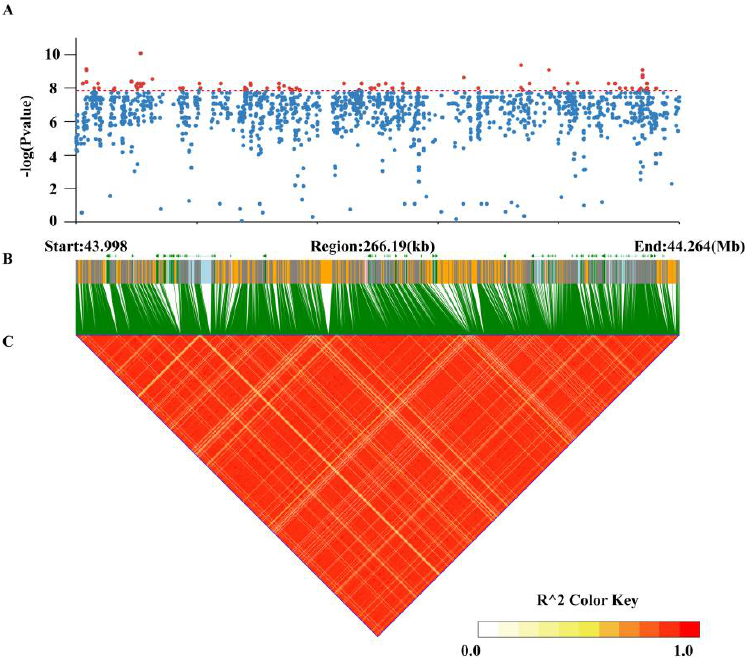
Figure 5. Manhattan plots and linkage disequilibrium (LD) heatmap over 266.29 kb around significant single-nucleotide polymorphisms (SNPs) on chromosome 2. ( A ) Manhattan plots of ST1-2019. The red dashed line represents the threshold (7.86). SNPs over the threshold are highlighted in red. ( B ) Annotated genes in the region. These CDS, introns, UTR, and intergenic regions are shown in green, light blue, pink, and orange, respectively. ( C ) The LD heatmap over the region. Colors are coded according to the r 2 color key. Table 1. Putative genes in the 266.19 kb of candidate region.